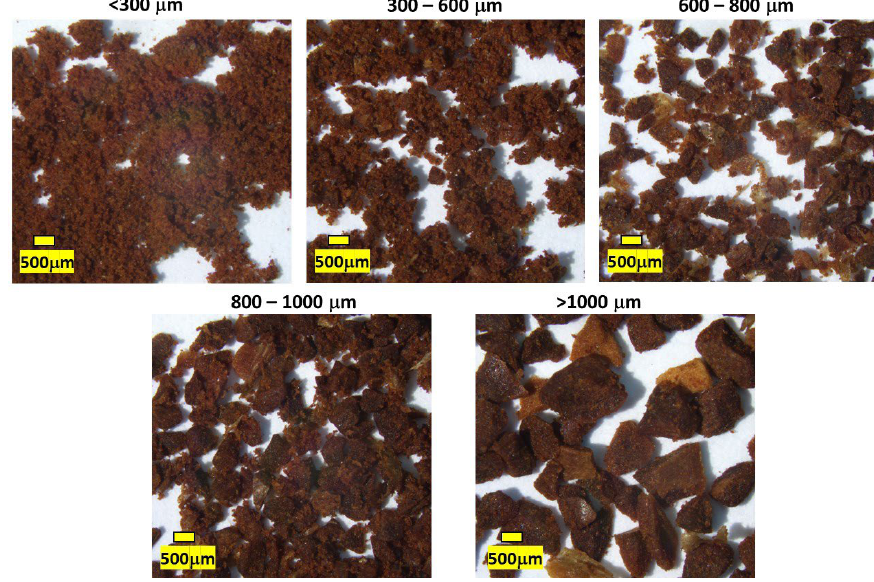
Figure 4. Illustration of ground coffee particle size. A light-medium roasted coffee was ground and separated into size bands using metal sieves.